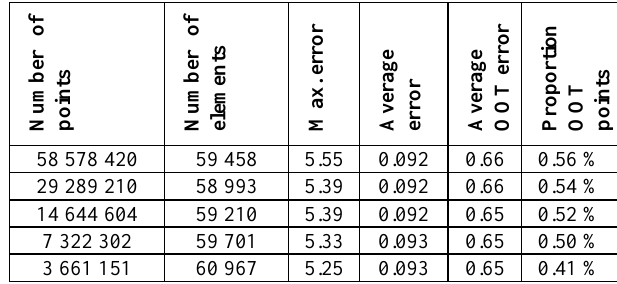
Table 1: Approximation data for thinned point cloud approximation (OOT =